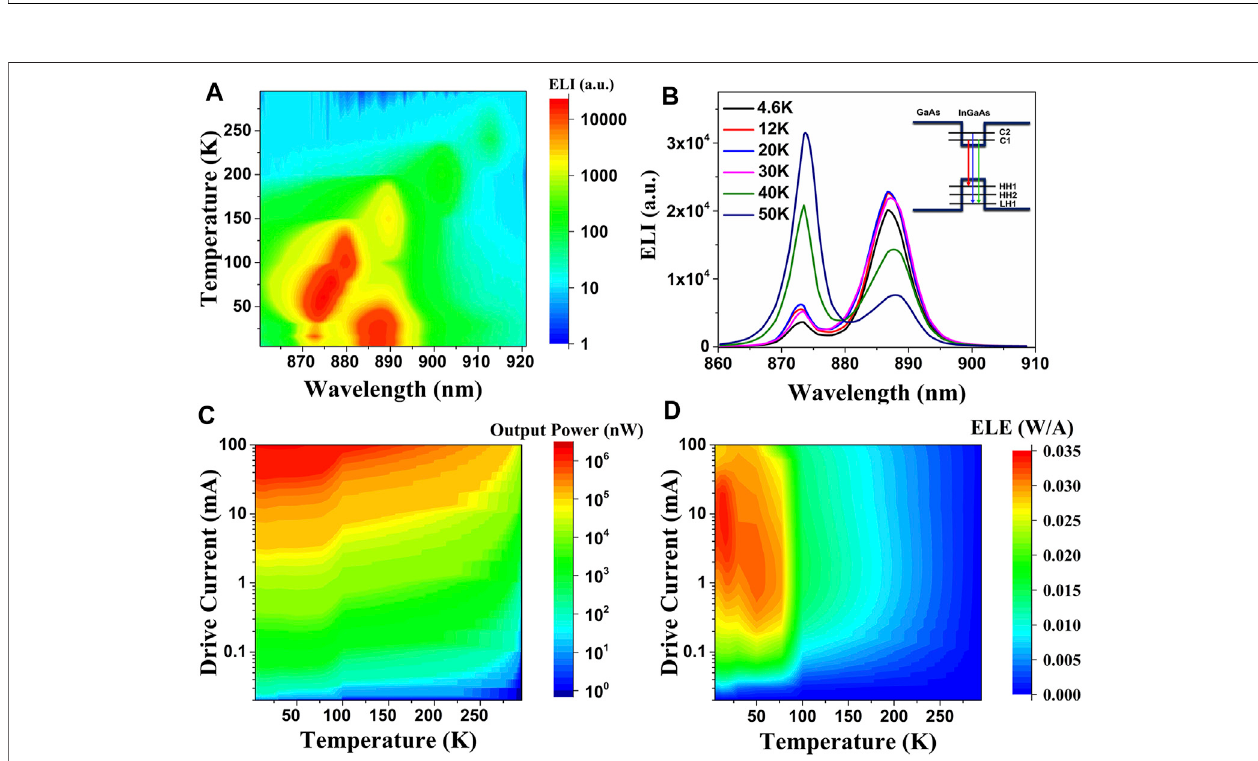
variationoftheoutputELpoweroftheLEDwiththebiasandtemperature. (D) ThemappingresultoftheELef fi